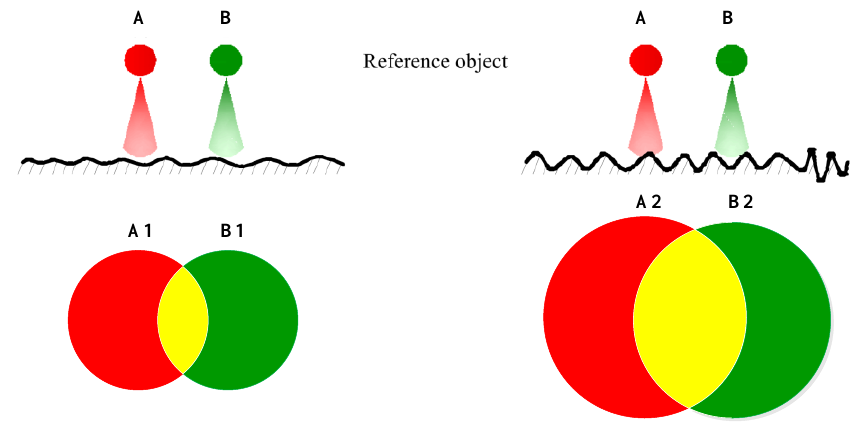
Figure 1. Reference object and its virtual image on different roughness surfaces.